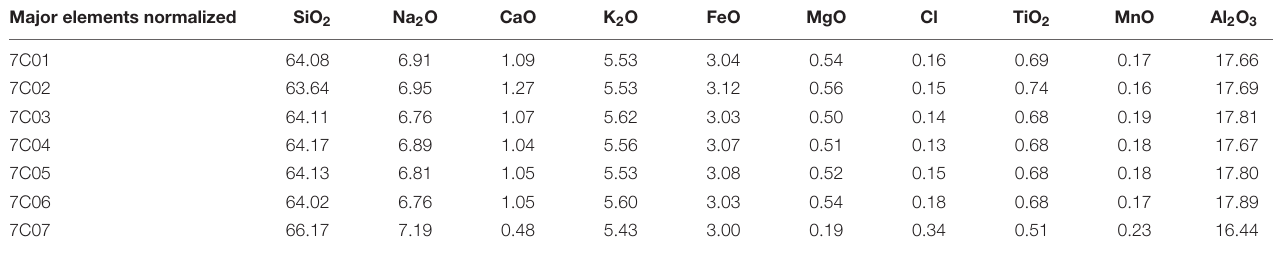
TABLE 3 | Overview of normalized values of major elements for the 7 different sample sets. Major elements normalized SiO